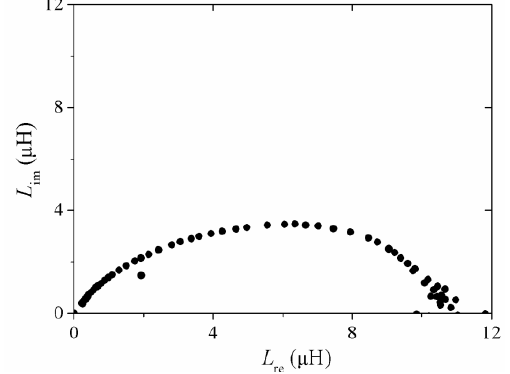
Figure 6. Cole-Cole representation for the complex inductance formalism